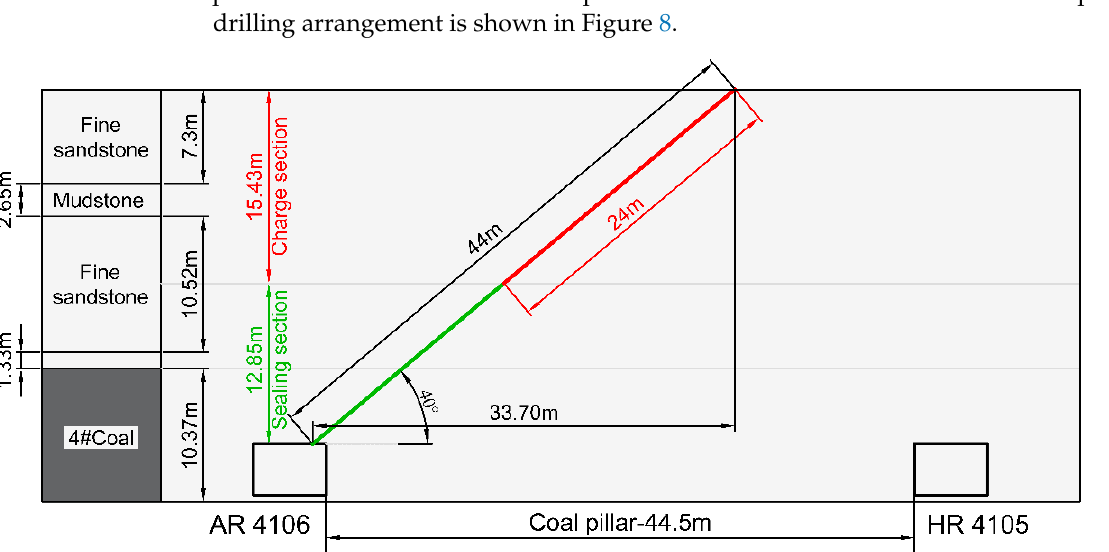
Figure 9. Monitoring data of roadway deformation under new support: ( a ) roadway deformation during tunneling and ( b ) deformation of roadway during mining of adjacent working face. Figure 9a shows that surface displacement initially increased rapidly after roadway tunneling and then gradually slowed and stabilized. The main convergent deformation occurred 20 m from the excavation face. The maximum roadway roof subsidence under the new scheme was 35 mm and the maximum convergence of the two sides was 58 mm. Deformation of the roof and two sides was reduced by 69.57% and 81.93%, respectively, compared with the original scheme (Table 1). Upon mining of WF 4105, the roof strata of